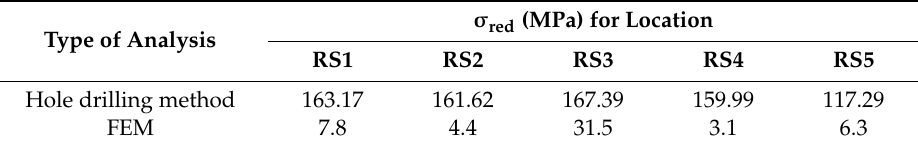
Table 9. Equivalent stress values at drilling